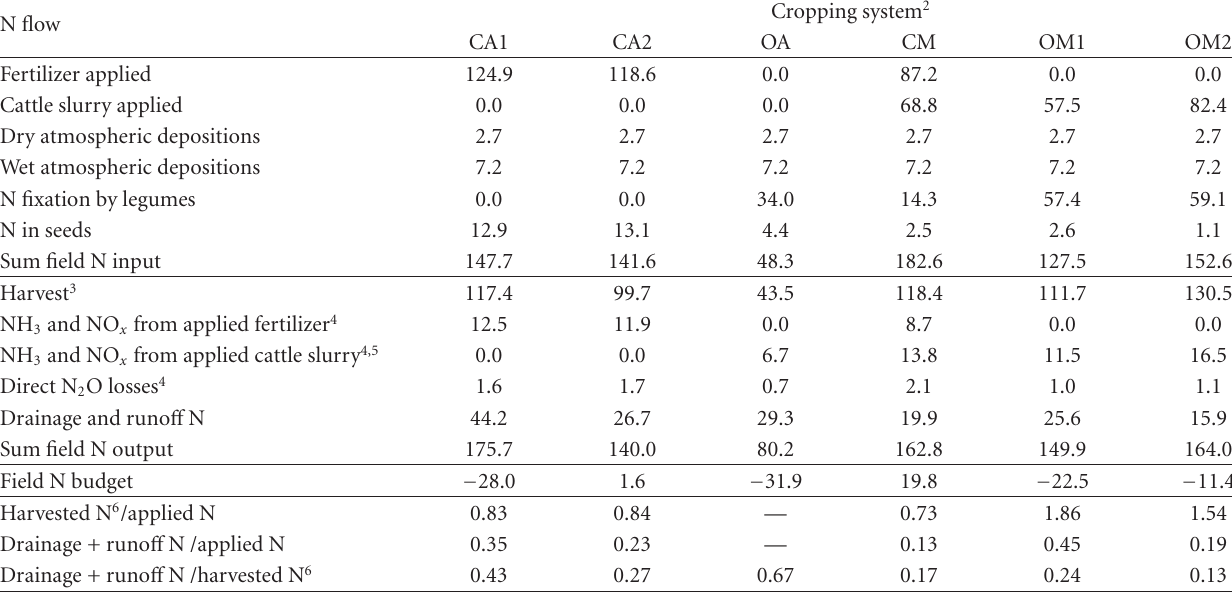
Table 5: Measured and estimated nitrogen flows (kgNha − 1 year − 1 ) and selected quotients (kgN kgN − 1 ) in the cropping systems at Apelsvoll, mean 2001–2010 1 .